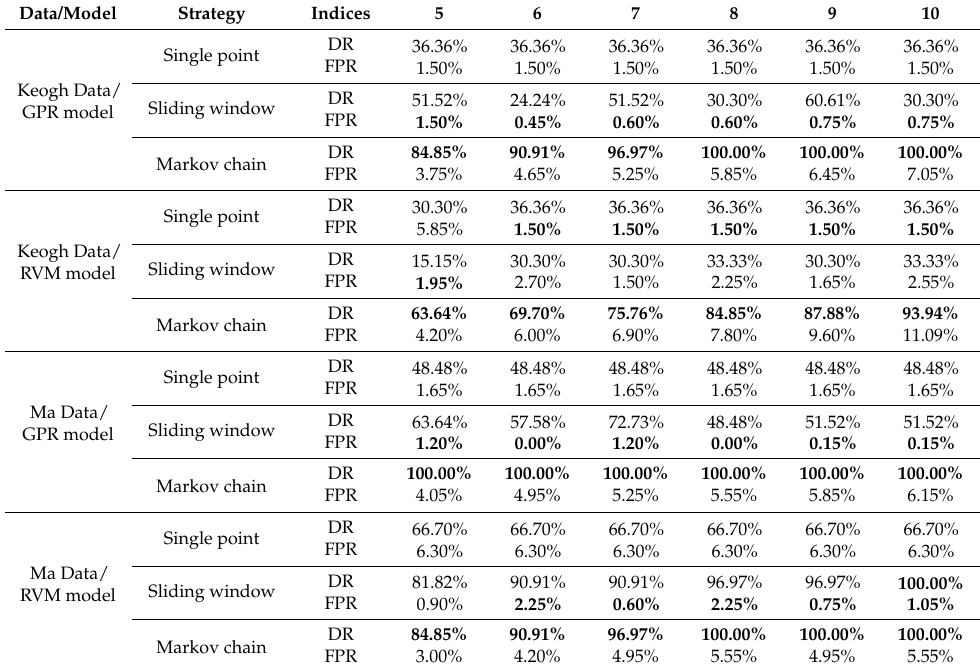
Table 1. The detection results with three labelling strategies under different sliding window sizes.